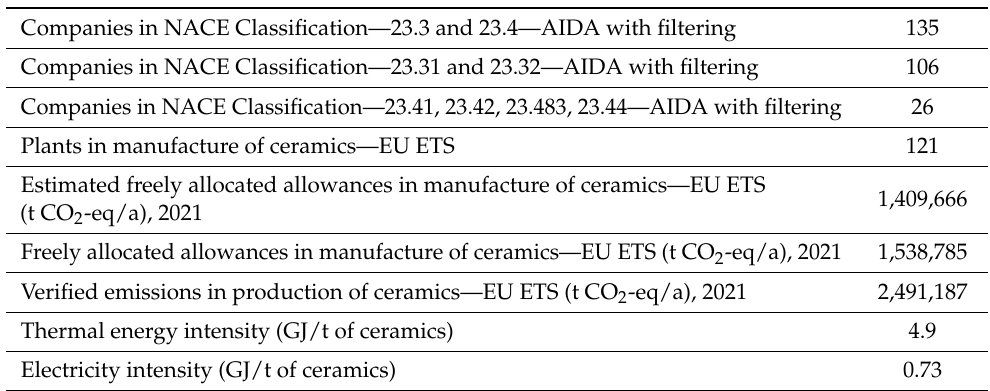
Table 6. Summary data for ceramics production plants in Italy under EU